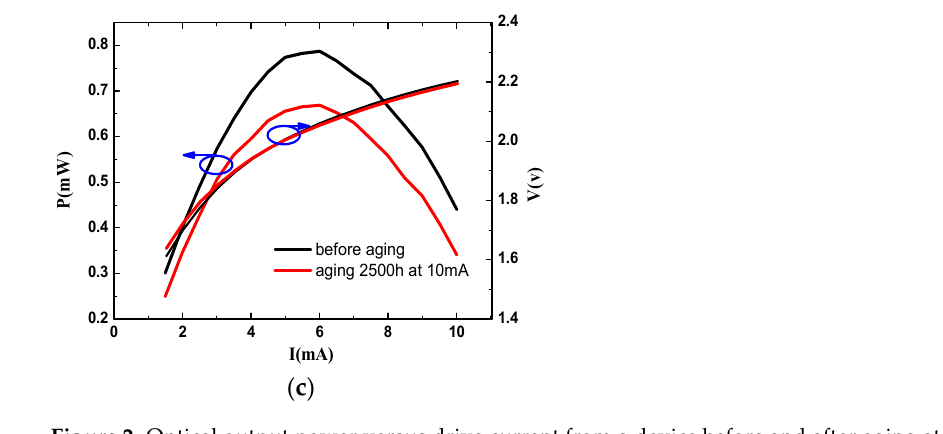
Figure 2. Optical output power versus drive current from a device before and after aging at ( a ) 6 mA, ( b ) 8 mA and ( c ) 10 mA, respectively.